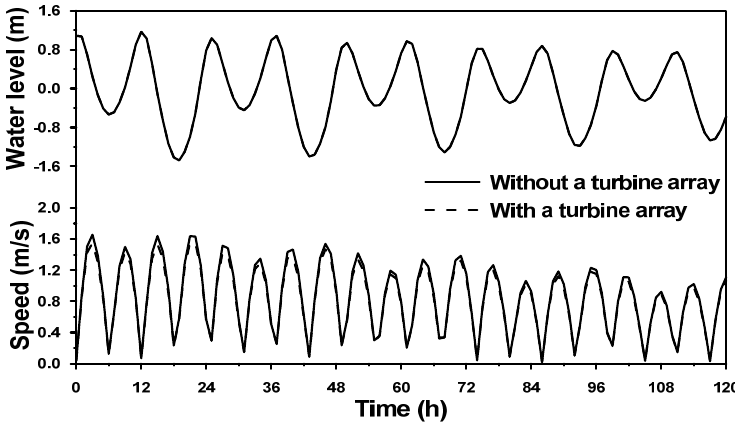
Figure 12. Time-series water level and tidal current with and without a turbine